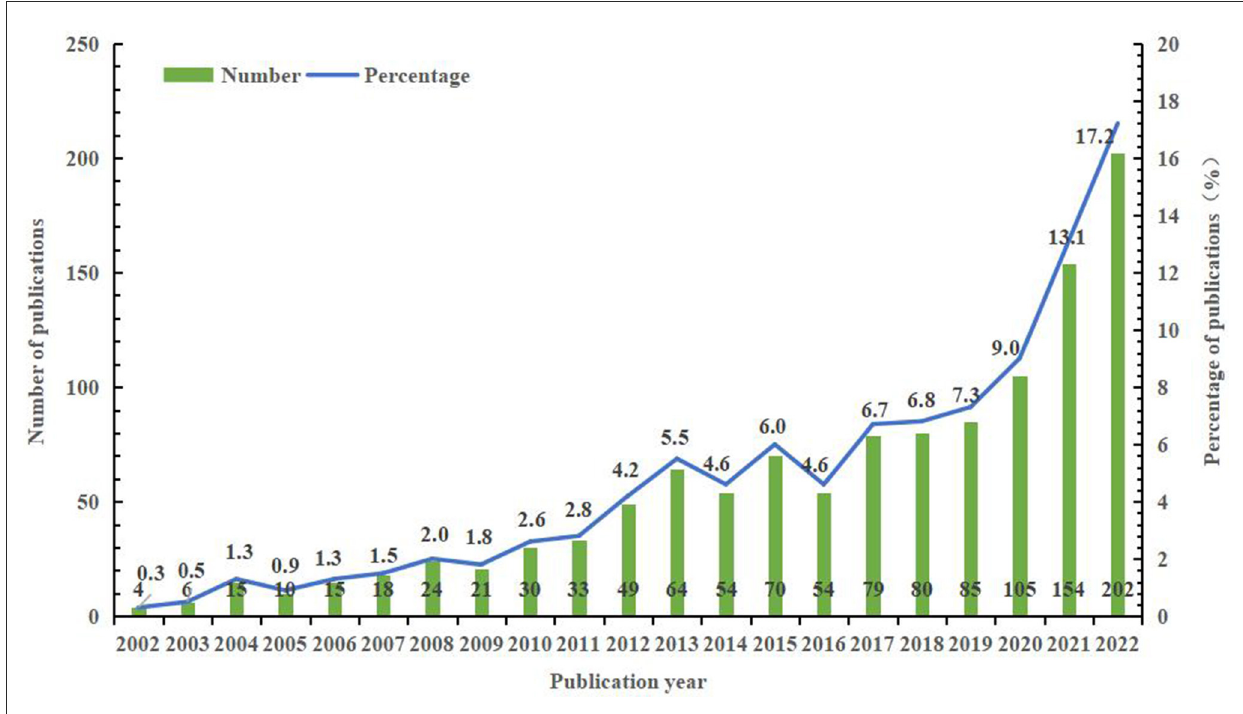
FIGURE1 The annual number of publications on sleep and cancer in the WOSCC database from 2002 to 2022.